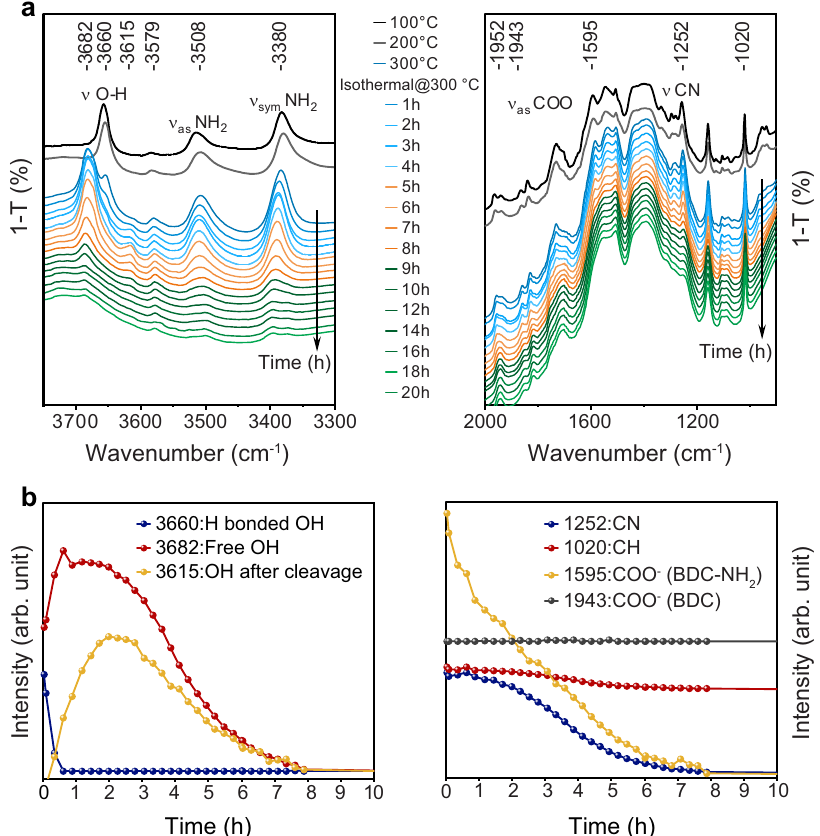
Fig. 5 Isothermal in situ DRIFTS study of 10%NH 2 -MIL. a DRIFTS spectra were collected during heating up to 300 °C and dwelling for 20 h. b Evolution of characteristic IR bands during the